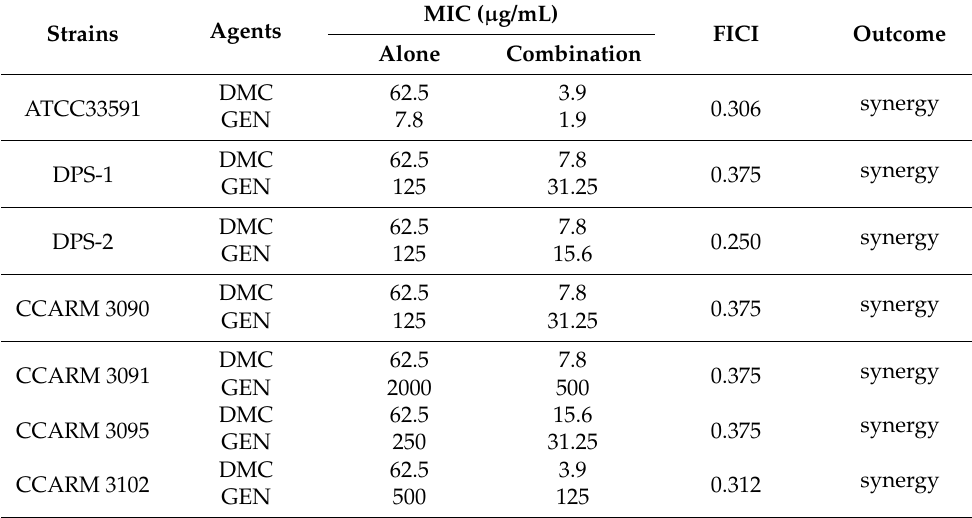
Table 2. Minimum inhibitory concentration (MIC) and fractional inhibitory concentration index (FICI) of demethoxycurcumin (DMC), and gentamicin (GEN) against seven methicillin-resistant Staphylococcus aureus (MRSA)